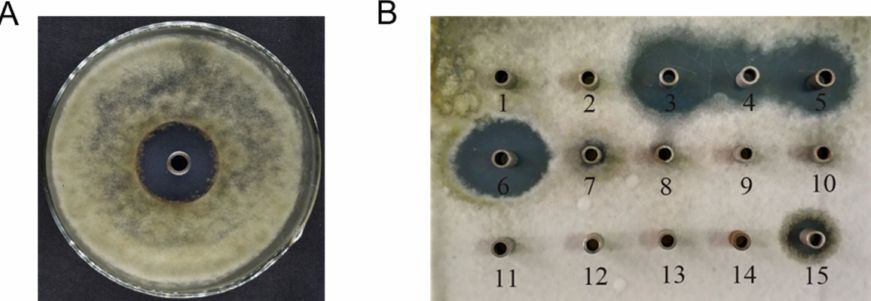
Figure 1. Anti-fungal activity of S. fungicidicus SYH3 fermentation broth against A. solani ( A ) and its active components obtained by isolation and purification ( B ). Table 1. Determination of inhibition rate and IC 50 values of four monomer compounds against A. solani. Mean ± standard deviation indicated by different letters are significantly different according to the Duncan’s multiple range test at p < 0.05.